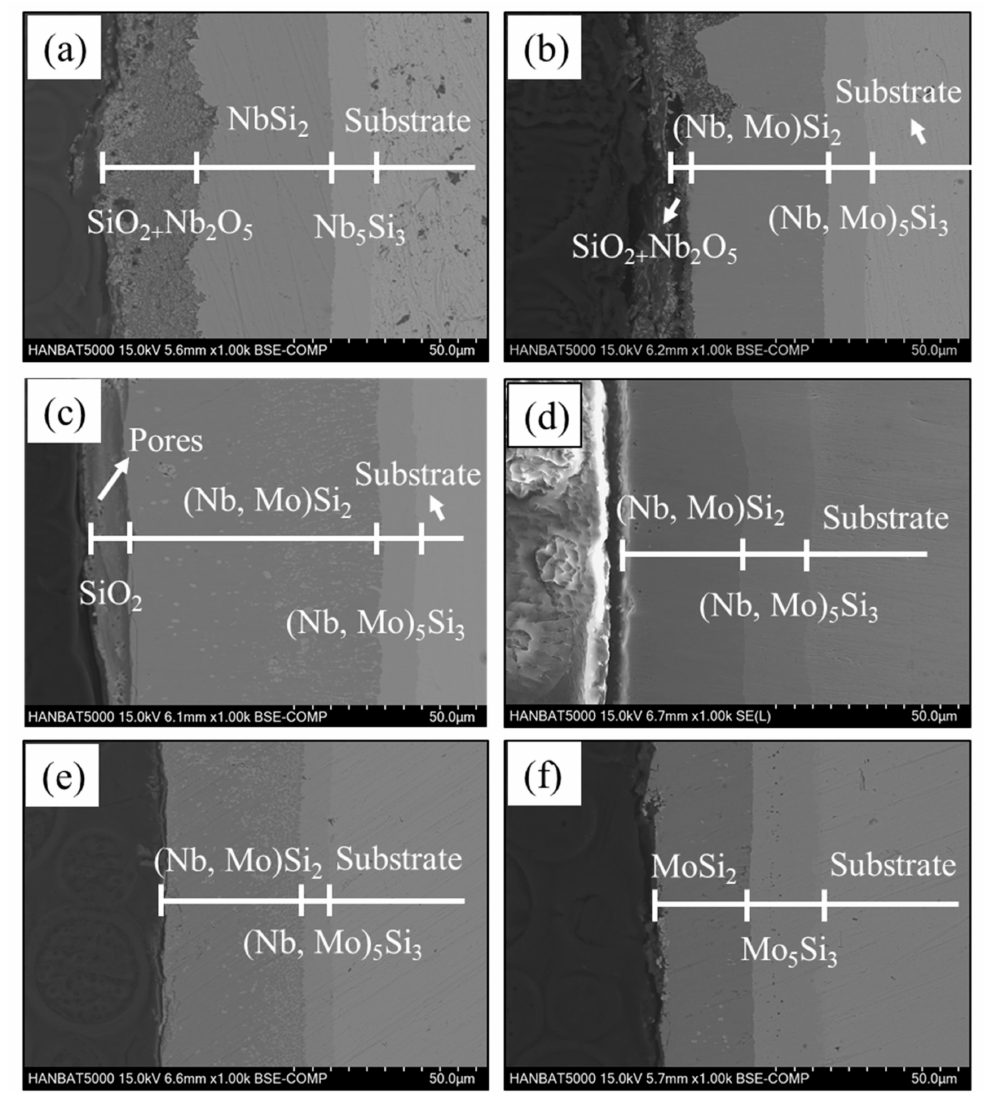
Figure 7. SEM BSE image of cross section of Si-pack-coated specimens after oxidation tests at 1200 ◦ C for 6 h with substrate compositions of ( a ) Alloy 1 (Nb), ( b ) Alloy 2 (Nb 73.6 Mo 26.4 ), ( c ) Alloy 3 (Nb 51.2 Mo 48.8 ), ( d ) Alloy 4 (Nb 35.1 Mo 64.9 ), ( e ) Alloy 5 (Nb 25.7 Mo 74.3 ), and ( f ) Alloy 6